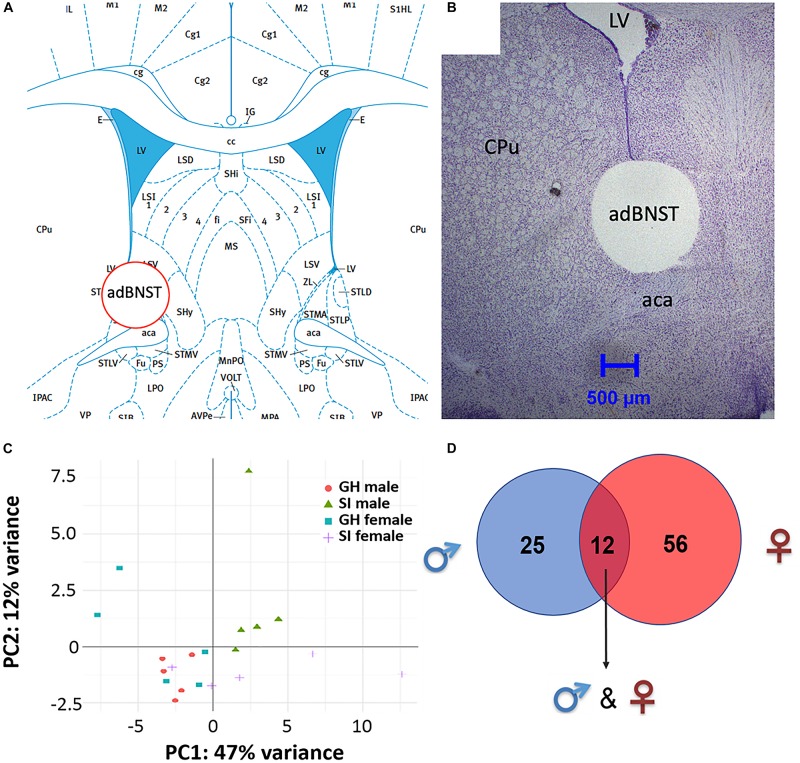
Visualization of the extracted anterodorsal bed nucleus of the stria terminalis (adBNST) and overview of differentially expressed (DE) miRNAs from the adBNST measured using small RNA sequencing. (A) Representative coronal brain atlas plate (Paxinos and Watson, 2007) of brain punch location. (B) Cresyl violet stained tissue section showing verification of brain punch location of rat adBNST. Note that the internal diameter of the corer used is 1-mm, which is approximately the width and height of the adBNST. Importantly, the outer diameter of the corer is 1.8-mm, which means that the cresyl violet histology pictures show a “hole” that is larger than the actual tissue punch. We processed tissue sections for each brain to examine the accuracy of our BNST punches (both beginning and end of tissue punch), and we discard data from any brains that have off-target BNST punches. Note that for this study, all BNST punches were on-target. (C) Principal component analysis showing the first two components of the regularized log2 transformed miRNA abundance data. Every dot represents a sample and they are colored by the condition information (see the legend). (D) A Venn diagram that indicates the number of DE miRNAs that reached significance in SI compared to GH controls in the adBNST in males (blue), females (red), or in both sexes (overlap of blue and red). GH, group housed; SI, socially isolated.